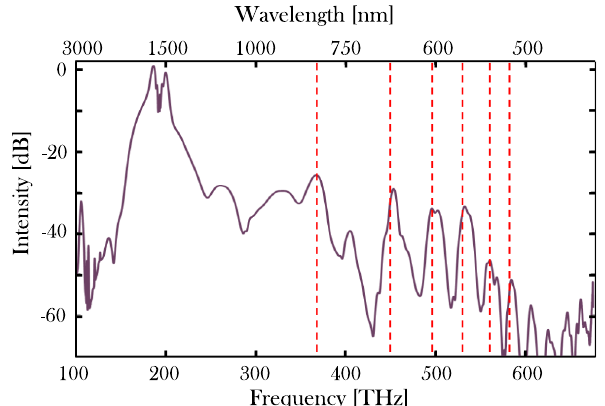
Fig. 2 A comparison of theoretically predicted and numerically simulated dispersive wave spectrum in a graded-index multimode fi ber. Dispersive wave (DW) spectrum as obtained from a gUPPE simulation right after the fi rst fi ssion event. The parameters used are identical to those of Fig. 1. Dotted lines indicate the discrete positions of the DW lines, as predicted by Eq.